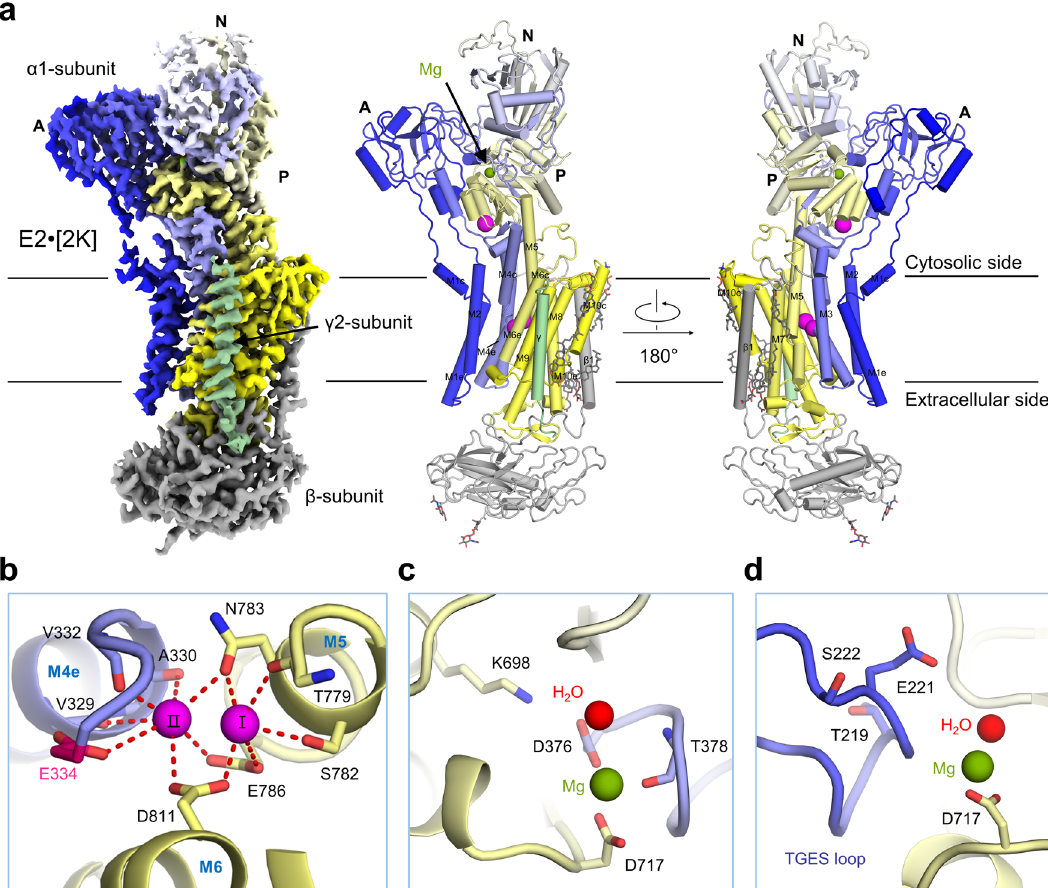
coloured grey; the γ 2 subunit is coloured pale green. b In the E2·2[K] state, two K + are bound to transmembrane K + binding sites (I and II). c Mg 2